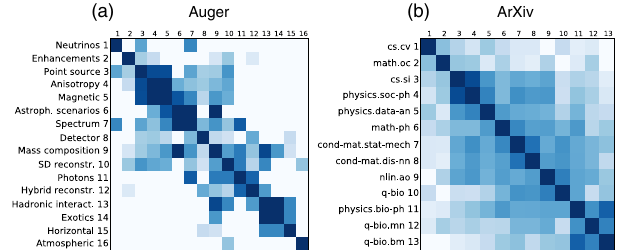
FIG. 5. Real multilayer networks with communities across network layers. The heat maps show the similarities between network layers, measured as the fraction of state nodes in different network layers that are assigned to the same communities.